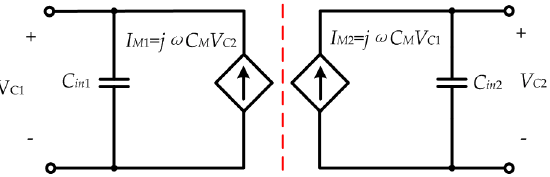
Figure 23. Equivalent behavior source model of a capacitive coupler.